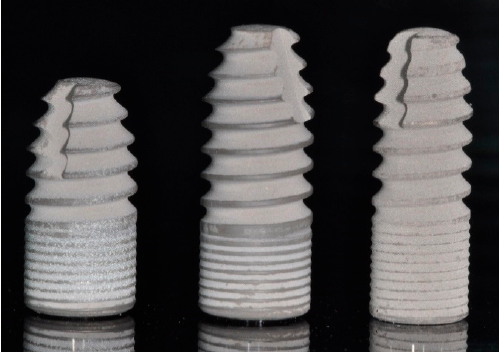
Figure 1. Implant dimensions used in this study: ( left ) implant dimension 4.8 × 10 mm; ( middle )